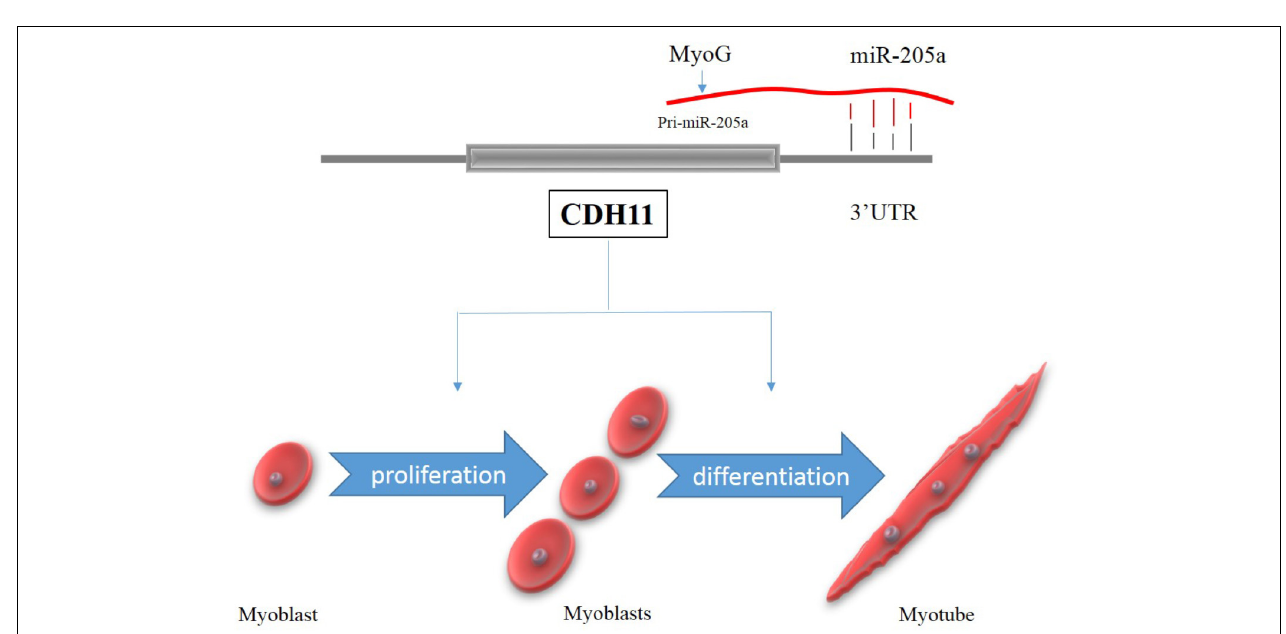
FIGURE 7 | A schematic model of CDH11 mediated regulatory network during myoblast proliferation and differentiation.